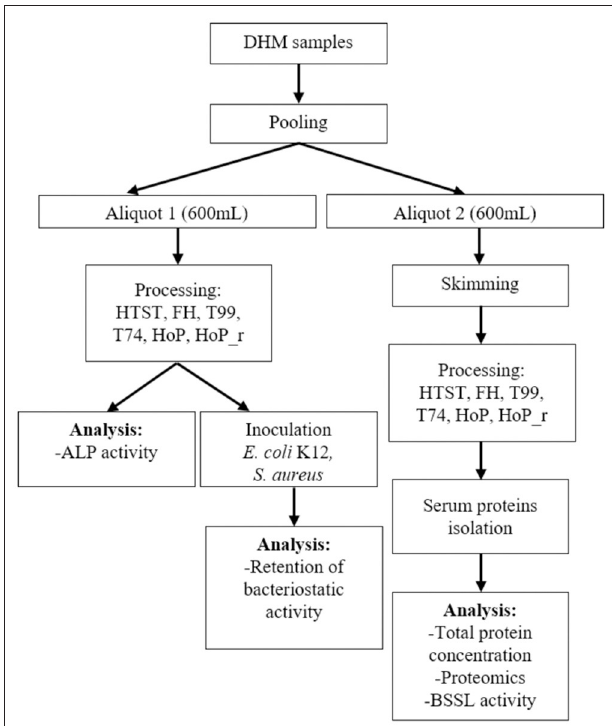
FIGURE 1 | Schematic workflow indicating the experimental approach used. HTST, FH, T99, T74, HoP and HoP_r stand for high-temperature short-time, flash heating, high-temperature short-time with a thermomixer preheated at 99 ◦ C, high-temperature short-time with a thermomixer preheated at 74 ◦ C, holder pasteurization and holder pasteurization with rapid heating up-times, respectively. For each heating method, DHM treatment was done in biological duplicate. Each sample was then aliquoted for the subsequent analyses, which were performed in technical duplicate.